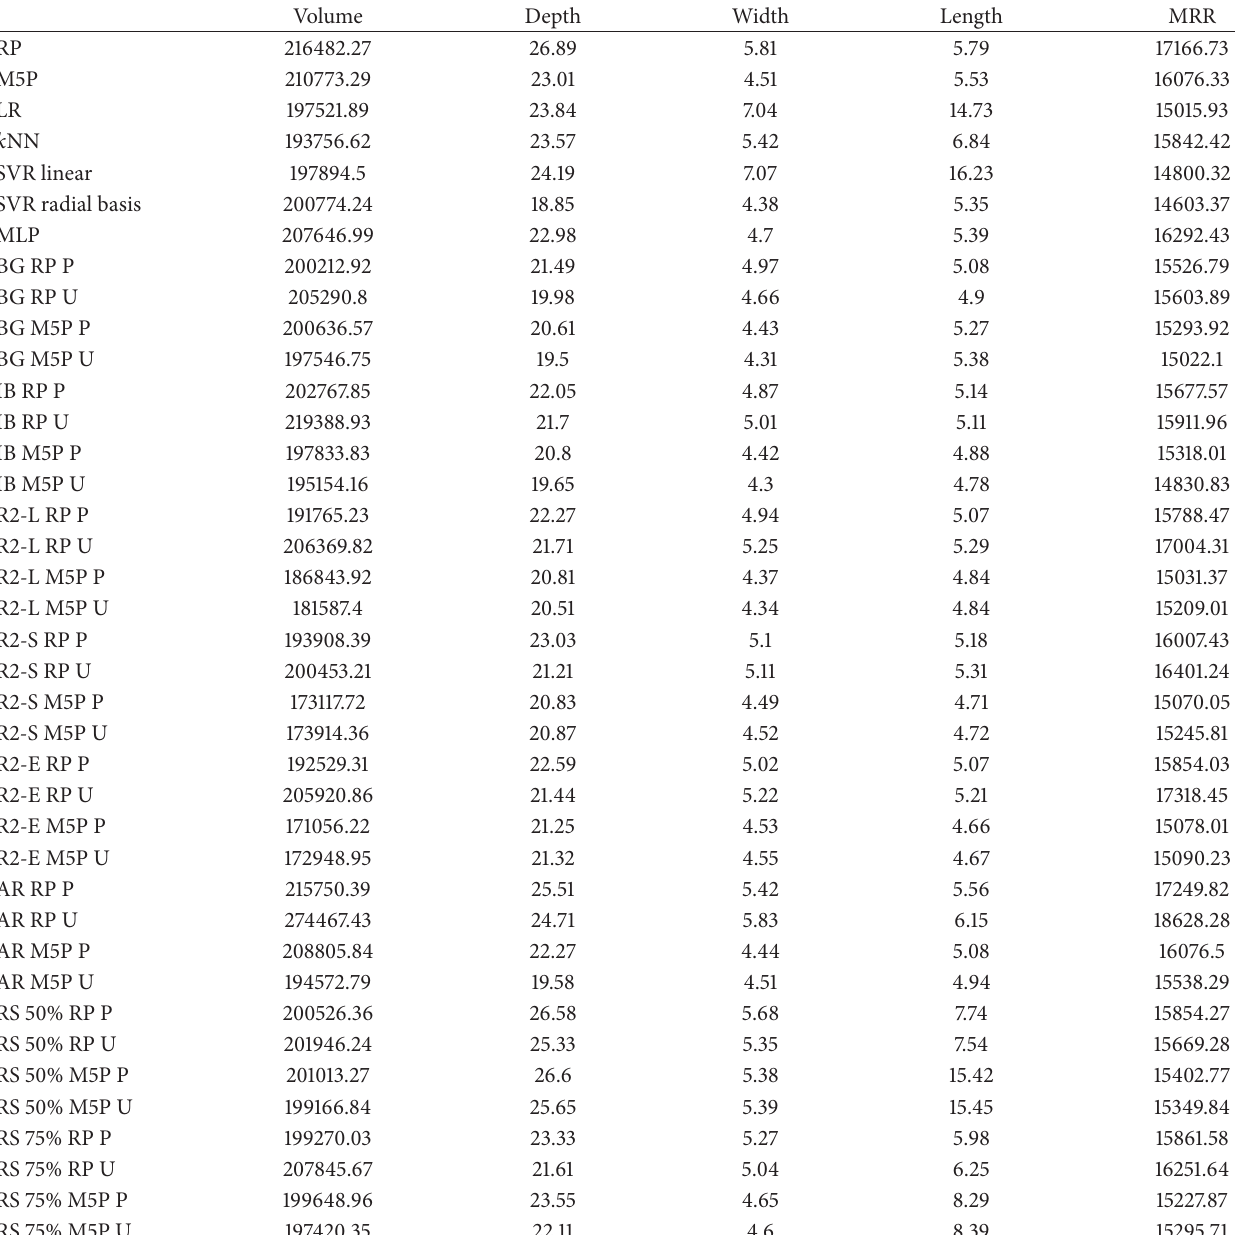
Table 7: Root mean squared error